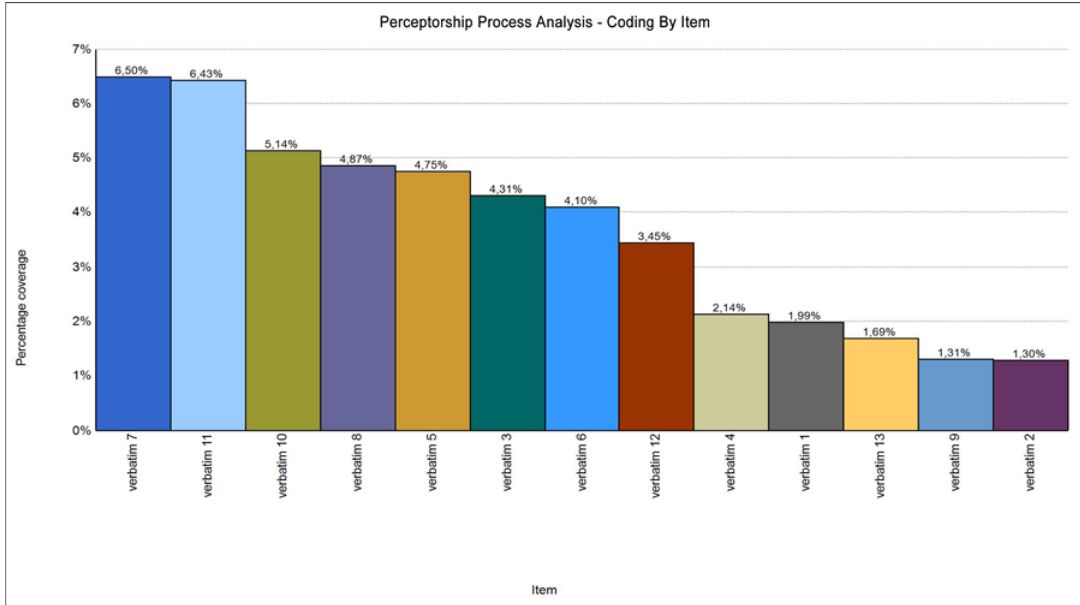
Fig. 8. Percentage showing the process for